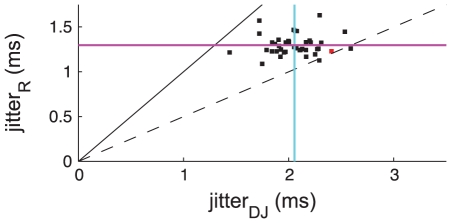
Temporal precision of isolated single spikes.Value along the abscissa shows single spike precision assessed by the dejittering algorithm for 40 cells (population mean shown as a vertical cyan line). Value along the ordinate shows single spike precision assessed by a raster-based analysis for the same cells (population mean shown as horizontal purple line). Each cell is represented by a single point (red point is from same recording shown in Figure 1A–C). The solid black line denotes where the two methods give equal results, while the dashed black line shows where the dejittering method gives a value twice as large as the raster analysis.